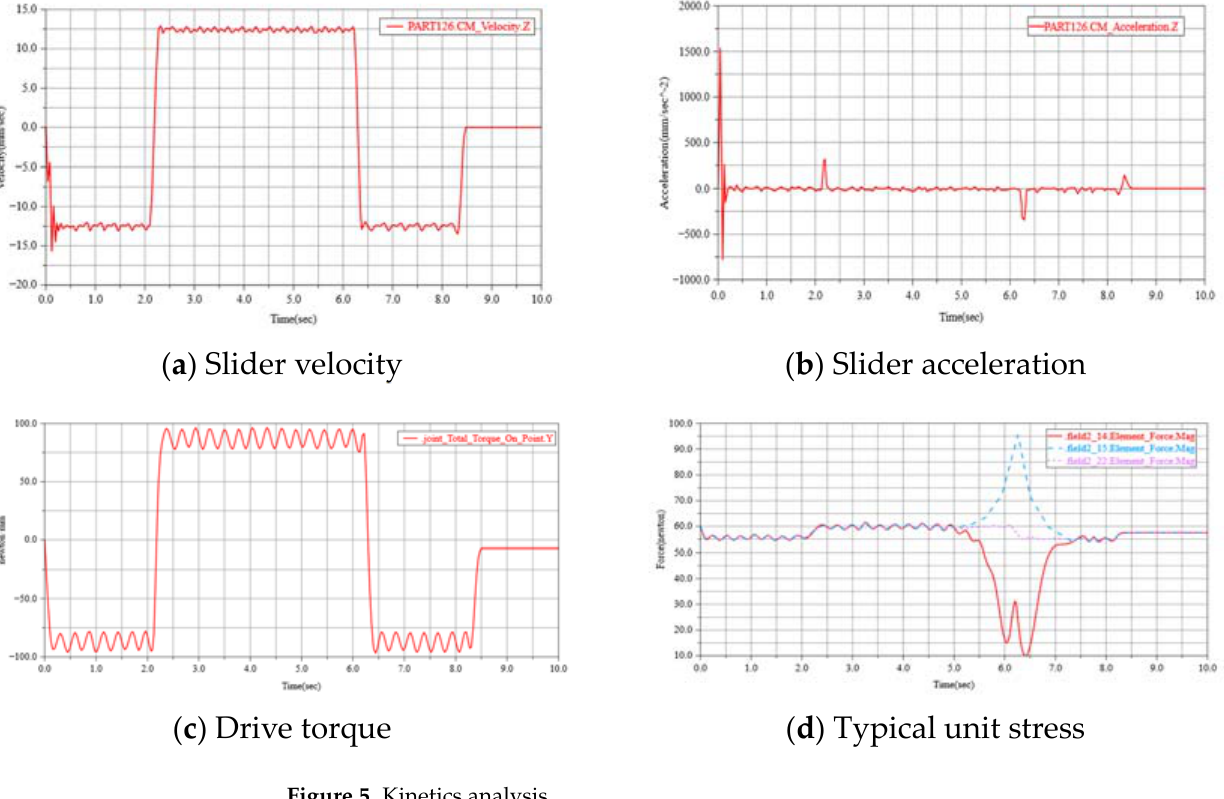
Figure 5. Kinetics analysis.